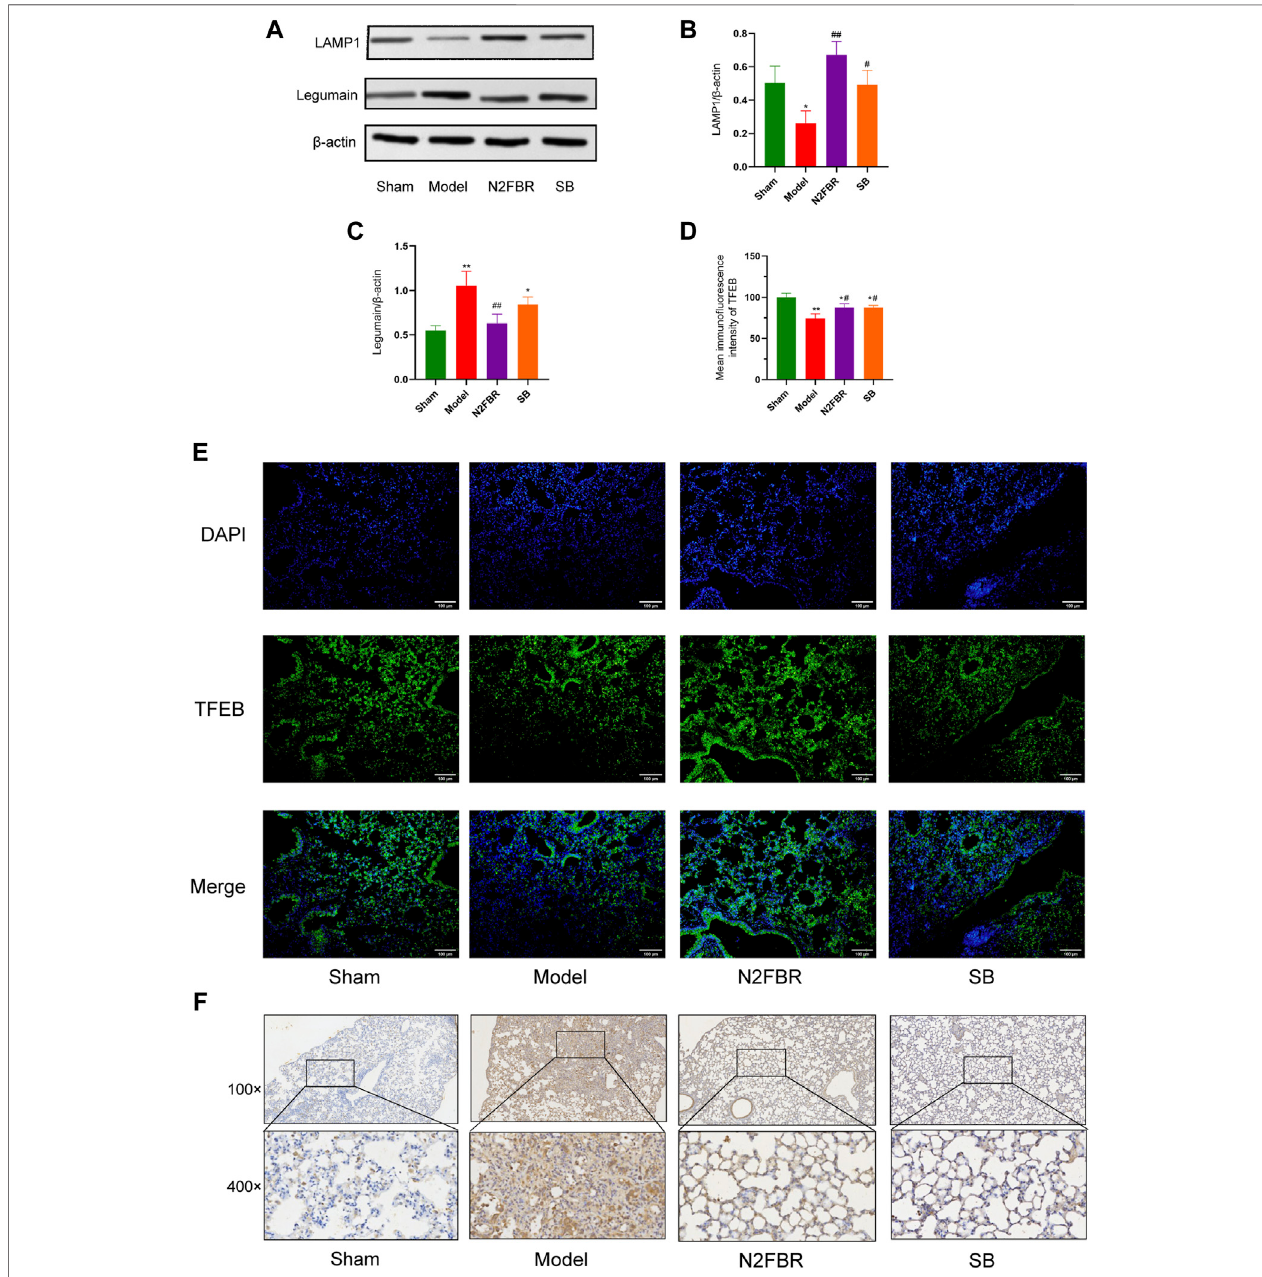
FIGURE6| EffectsofN2FBRonlysosomeinjury. (A) ProteinlevelsofLAMP1andLegumainasdeterminedbywesternblotting.Relativedensityvaluesshowing (B) LAMP1 and (C) Legumain expression. (D) Mean immuno fl uorescence intensity of TFEB. (E) Representative images of immuno fl uorescence showing the expression of TFEB. (F) Representative images of immunohistochemical staining for Legumain. Data are expressed as * p < 0.05, ** p < 0.01, compared with sham group; # p < 0.05, ## p < 0.01, compared with model group.